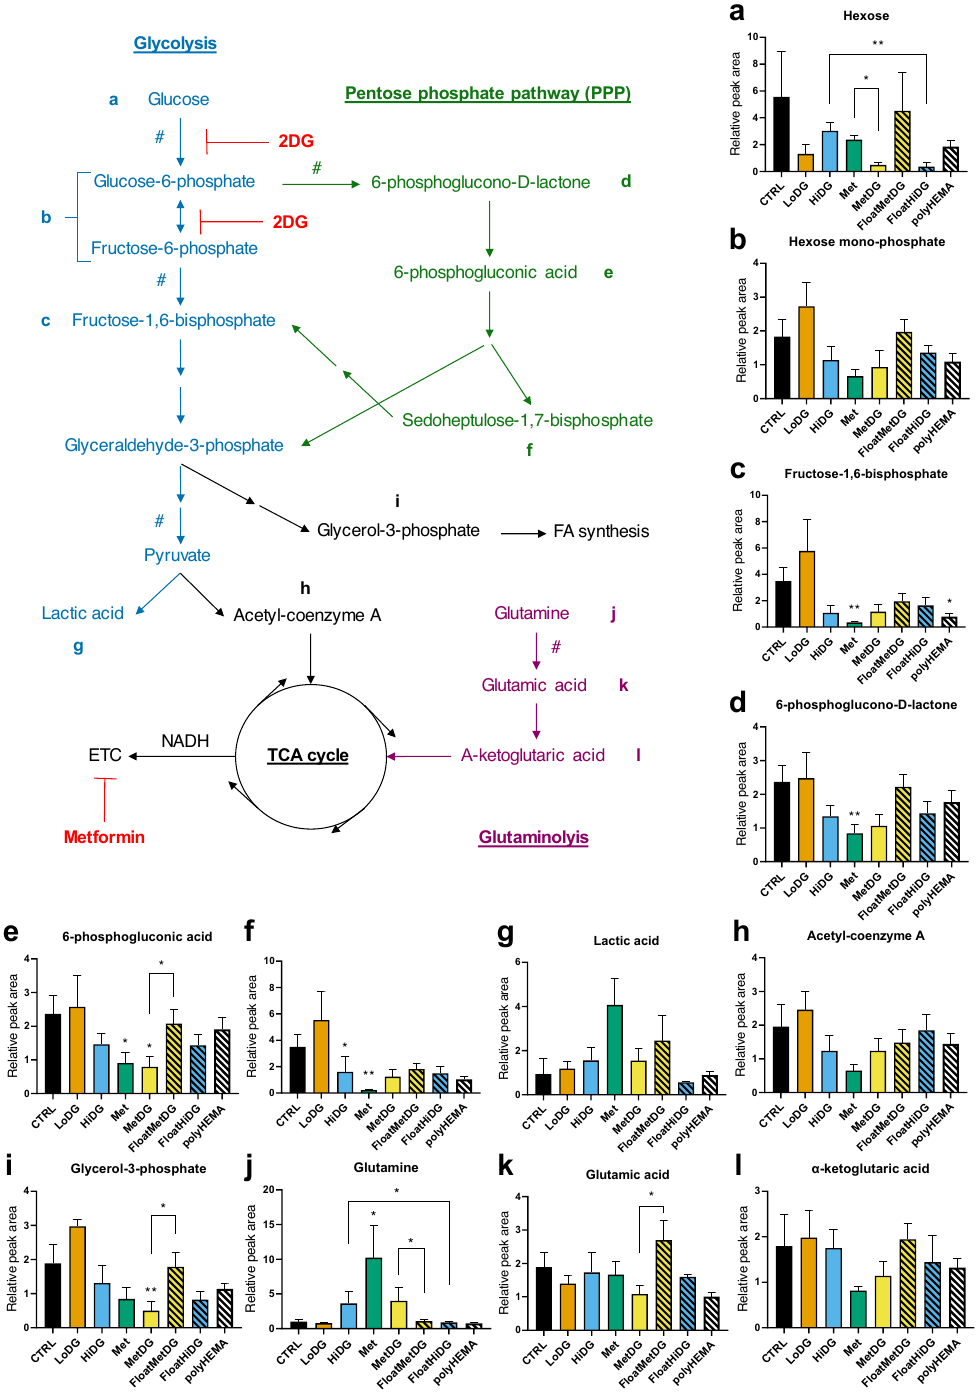
Figure 5. Glycolysis and PPP metabolite levels per treatment groups and their floating populations. Metabolite levels were QC-normalized and mapped to glycolysis and pentose phosphate pathway to show the metabolic reactions in the cell. A single arrow denotes direct conversion in a single reaction and a segmented arrow denotes conversion with multiple step reactions. Rate limiting reactions are marked with #. Samples are color- coded and samples with floating cells are hatched. All graphs show mean relative normalized metabolite peak areas ± standard error (SEM). Please note y-axis scales are different between the plots. * p < 0.05, ** p < 0.01 versus CTRL unless otherwise